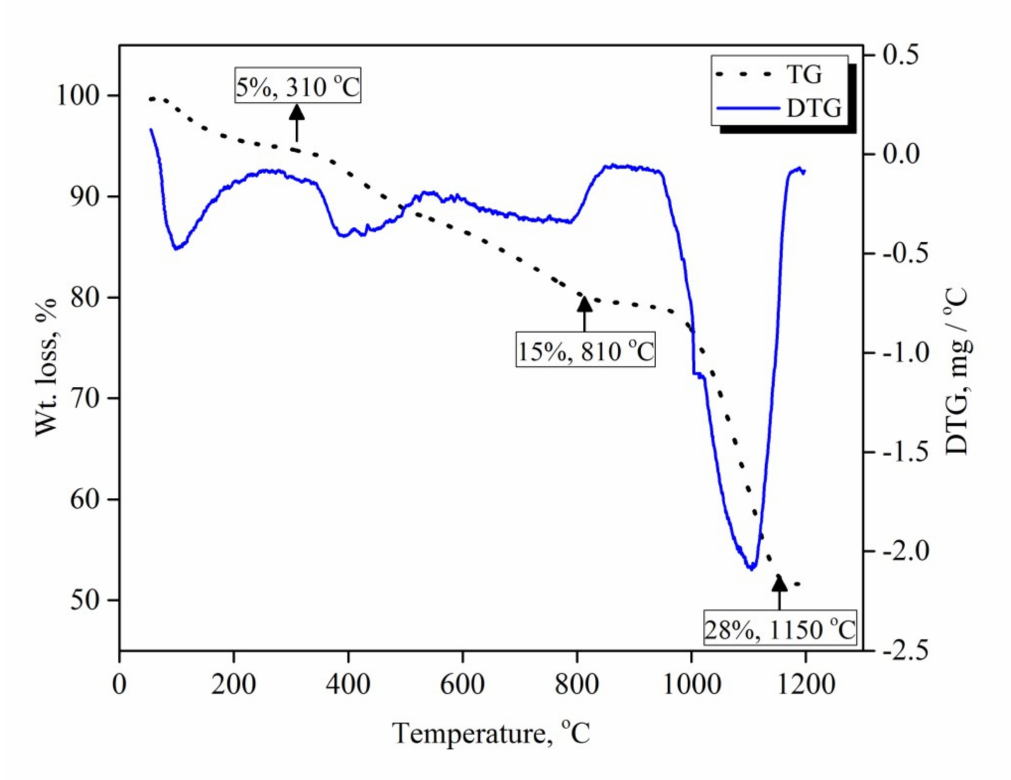
Figure 2. TGA-DTG curves of 15 hr mechanically activated V 2 O 5 -carbon black